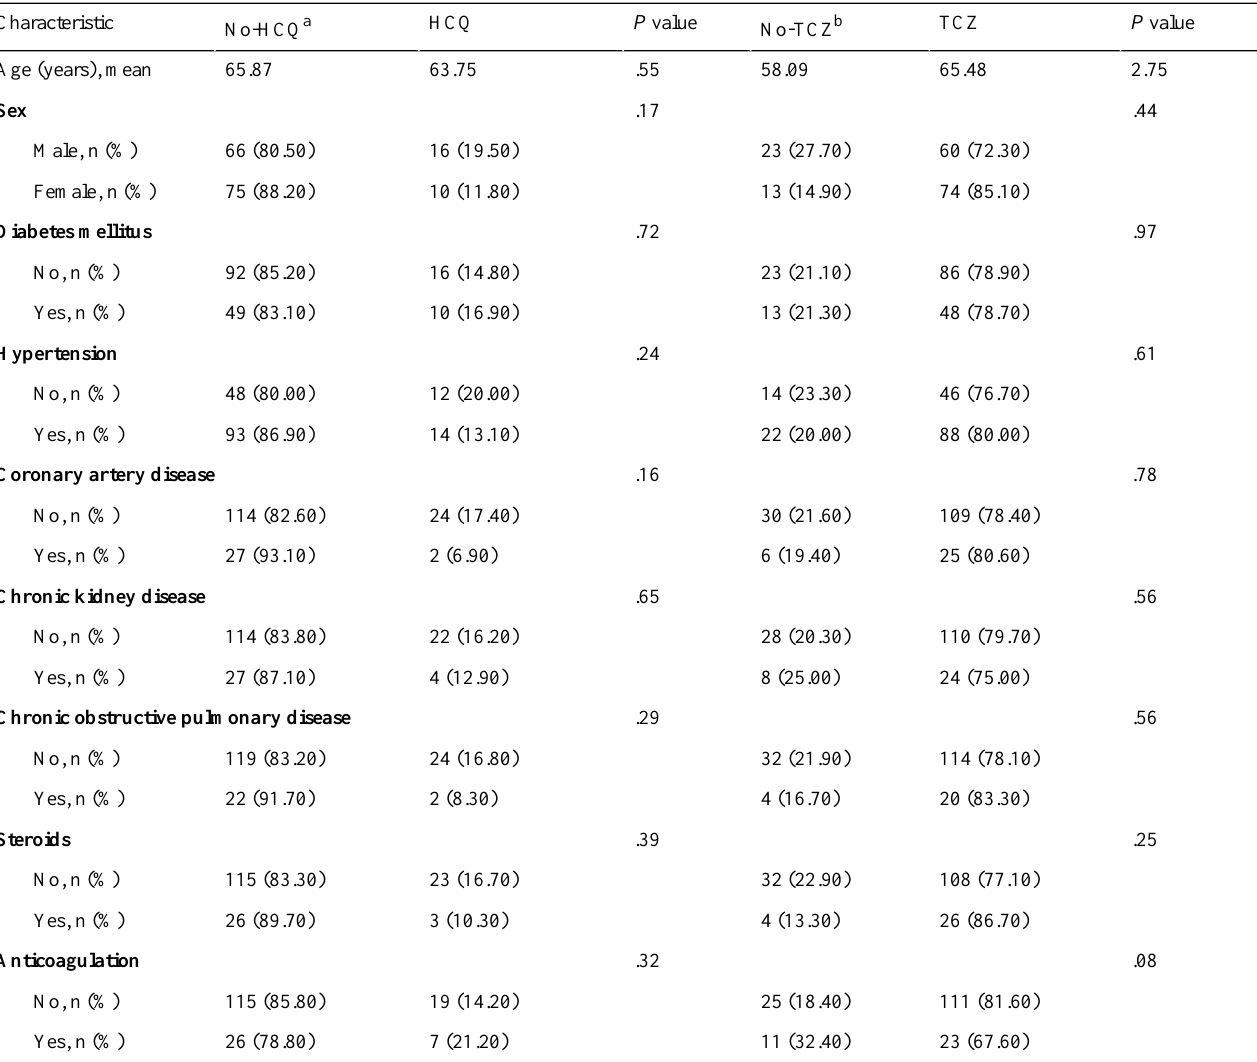
Table 1. Baseline characteristics of the included population across comparison